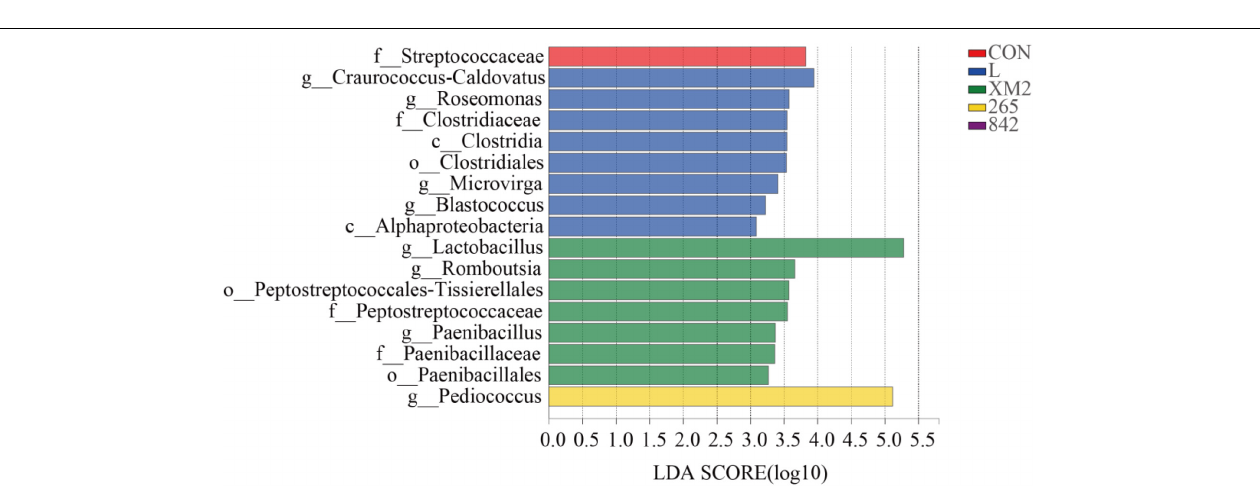
FIGURE 3 | The linear discrimination analysis (LDA) coupled on the bacterial community of native grass on 30 days of ensiling with effect size (LEfSe) analysis. The significant difference in species was estimated by an LDA score greater at default score = 3. The length of the histogram shows the LDA score of differences in these groups. CON, control group; L, commercial inoculant group; XM2, strain XM2 group; 265, strain 265 group; 842, strain 842